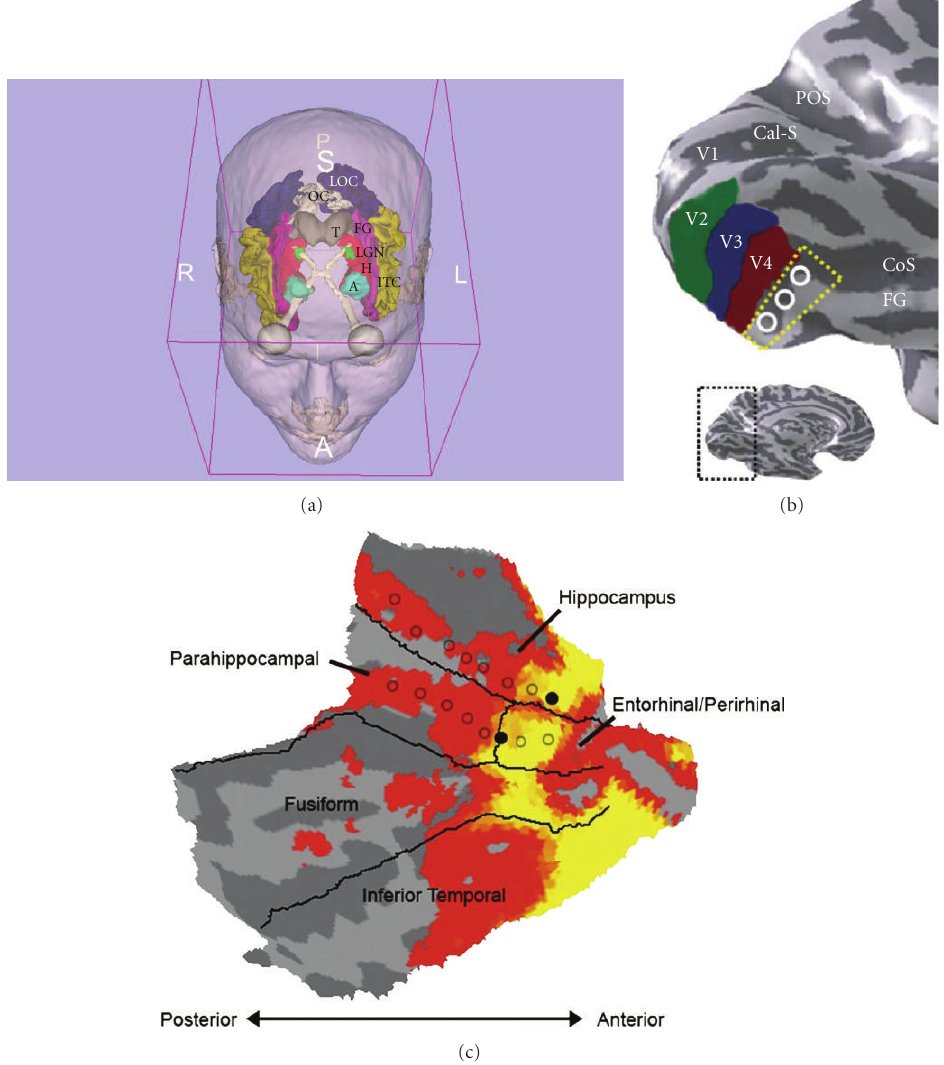
Figure 1: Parcellation of the human visual cortex and brain areas involved in visual object perception: (a) eye bulb—grey, optical tract/optical chiasm—white, lateral geniculate nucleus (LGN)—green, occipital visual cortex (OC)—white, lateral occipital gyrus (LOC)—navy blue, inferior temporal gyrus (ITC)—creamy yellow, fusiform gyrus (FG)—magenta, hippocampus (H)—red, amygdala (A)—cyan, thalamus (T)—grey (created using the 3D Brain Slicer [38]). (b) Ventral occipital visual field map models: Cal-S (V1)—calcarine sulcus, V2—green, V3—blue, V4 (brick red), FG—fusiform gyrus, CoS—collateral sulcus, POS—parietal occipital sulcus. The dotted yellow line and white circles denote the region of cortex in which the V4 and V8 models diverge (inset shows inflated model of the left human hemisphere). (c) Anterior part of the fusiform gyrus is located in the vicinity of the hippocampal formation. (b) reproduced, with permission, from [25] Macmillan Publishers Ltd. (c) (right) reproduced, with permission, from [39] the American Physiological